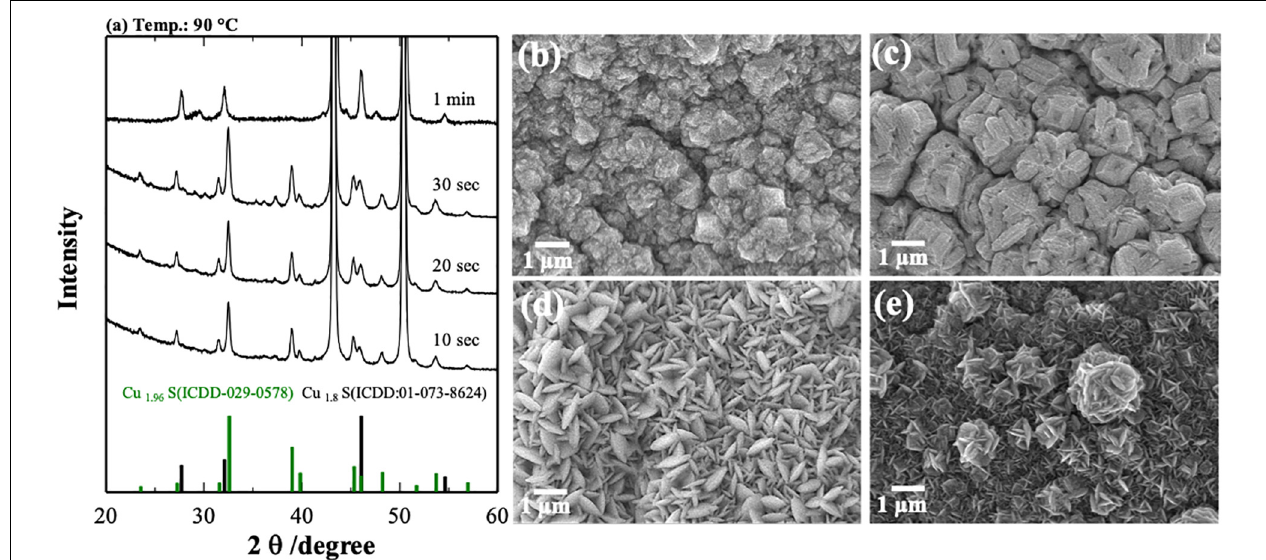
FIGURE 3 | X-ray powder diffraction patterns (a) and SEM pictures of Cu x S samples obtained at different times with the constant temperature of 90 ◦ C: (b) 10 s, (c) 20 s, (d) 30 s, and (e) 1 min.